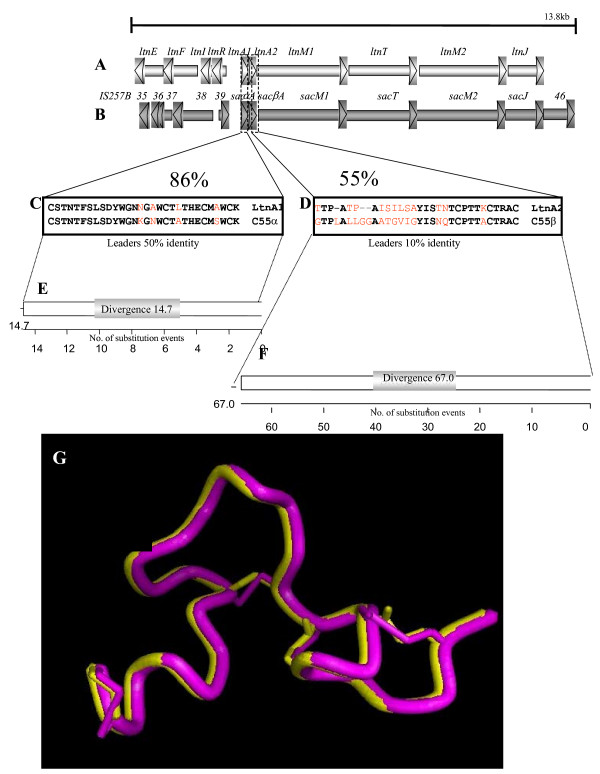
Genetic organisation of the gene clusters of the closely related lantibiotics lacticin 3147 (A) and staphylococcin C55 (B). C depicts a comparison of the amino acid sequence of the propeptide of one of the structural components of lacticin 3147 (LtnA1) and staphylococcin C55 (C55α). D depicts a comparison of the amino acid sequence of the propeptide of one of the structural components of lacticin 3147 (LtnA2) and staphylococcin C55 (C55β). Homologous amino acids are indicated in bold, differences are indicated in red. E and F indicates evolutionary divergence (measured in the number of substitution events) between the unmodified lantibiotic propeptides (E) LtnA1 and C55α and (F) LtnA2 and C55β. (G) Visualization of homology modeling of LtnA1 (gold) and C55α (purple).